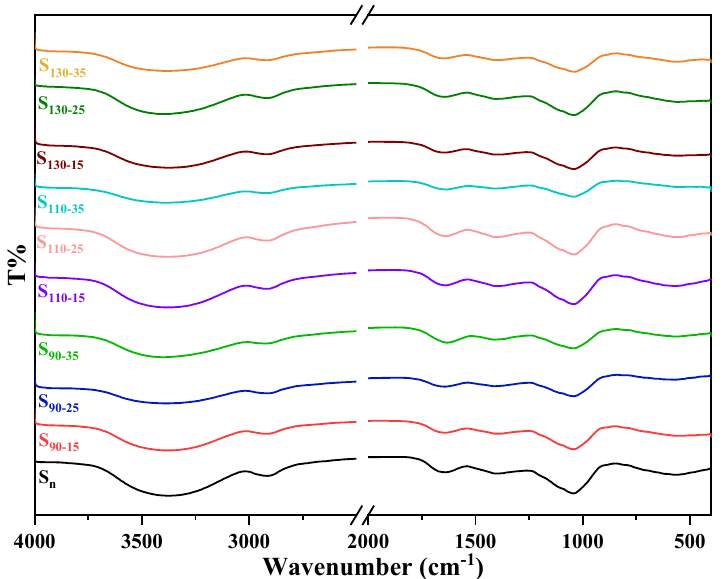
Figure 3. FTIR spectra of native and HMT HB flour. S n indicates native HB flour; S 90 − 15 , S 90 − 25 , S 90 − 35 indicate that the heating temperature of HB flour is 90 °C; S 110 − 15 , S 110 − 25 , S 110 − 35 indicate that the heating temperature of HB flour is 110 °C; S 130 − 15 , S 130 − 25 , S 130 − 35 indicate that the heating temperature of HB flour is 130 °C; S 90 − 15 , S 110 − 15 , S 130 − 15 indicate that the moisture content of HB flour is 15%; S 90 − 25 , S 110 − 25 , S 130 − 25 indicate that the moisture content of HB flour is 25%; S 90 − 35 , S 110 − 35 , S 130 − 35 indicate that the moisture content of HB flour is 35%; T%, transmittance (%). Table 4. Absorbance ratio of native and HB flours.